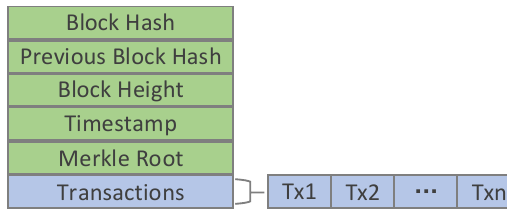
Figure 5. The structure of the block.